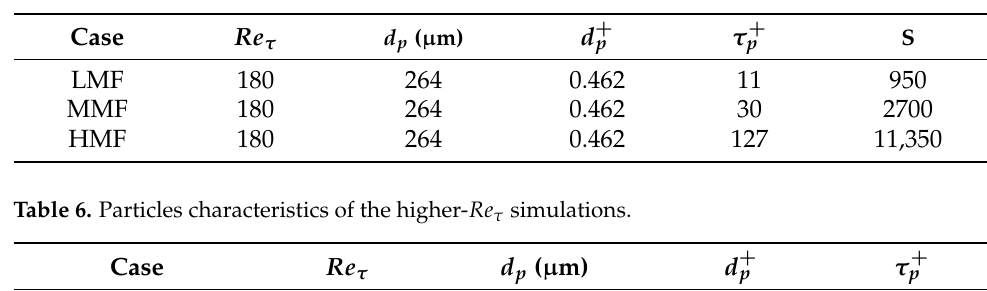
Table 5. Particles characteristics used in the production simulations for the High (HMF), Medium (MMF), and Low (LMF) particles mass fraction.